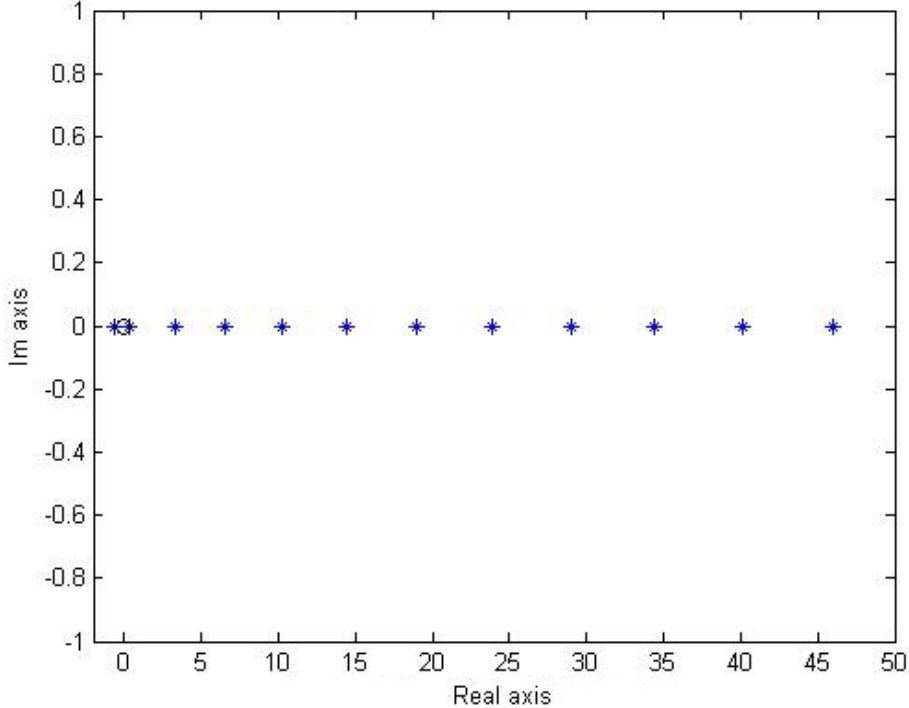
Figure 9. Phase portrait of the PDM Hamiltonian associated with double well potential for λ = 0.1.